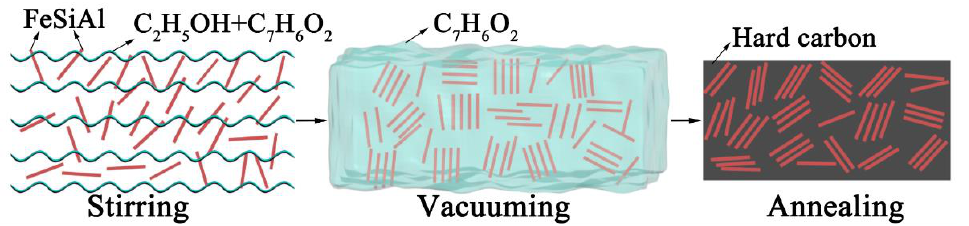
Figure 1. Schematic of the fabrication of the FeSiAl@HC